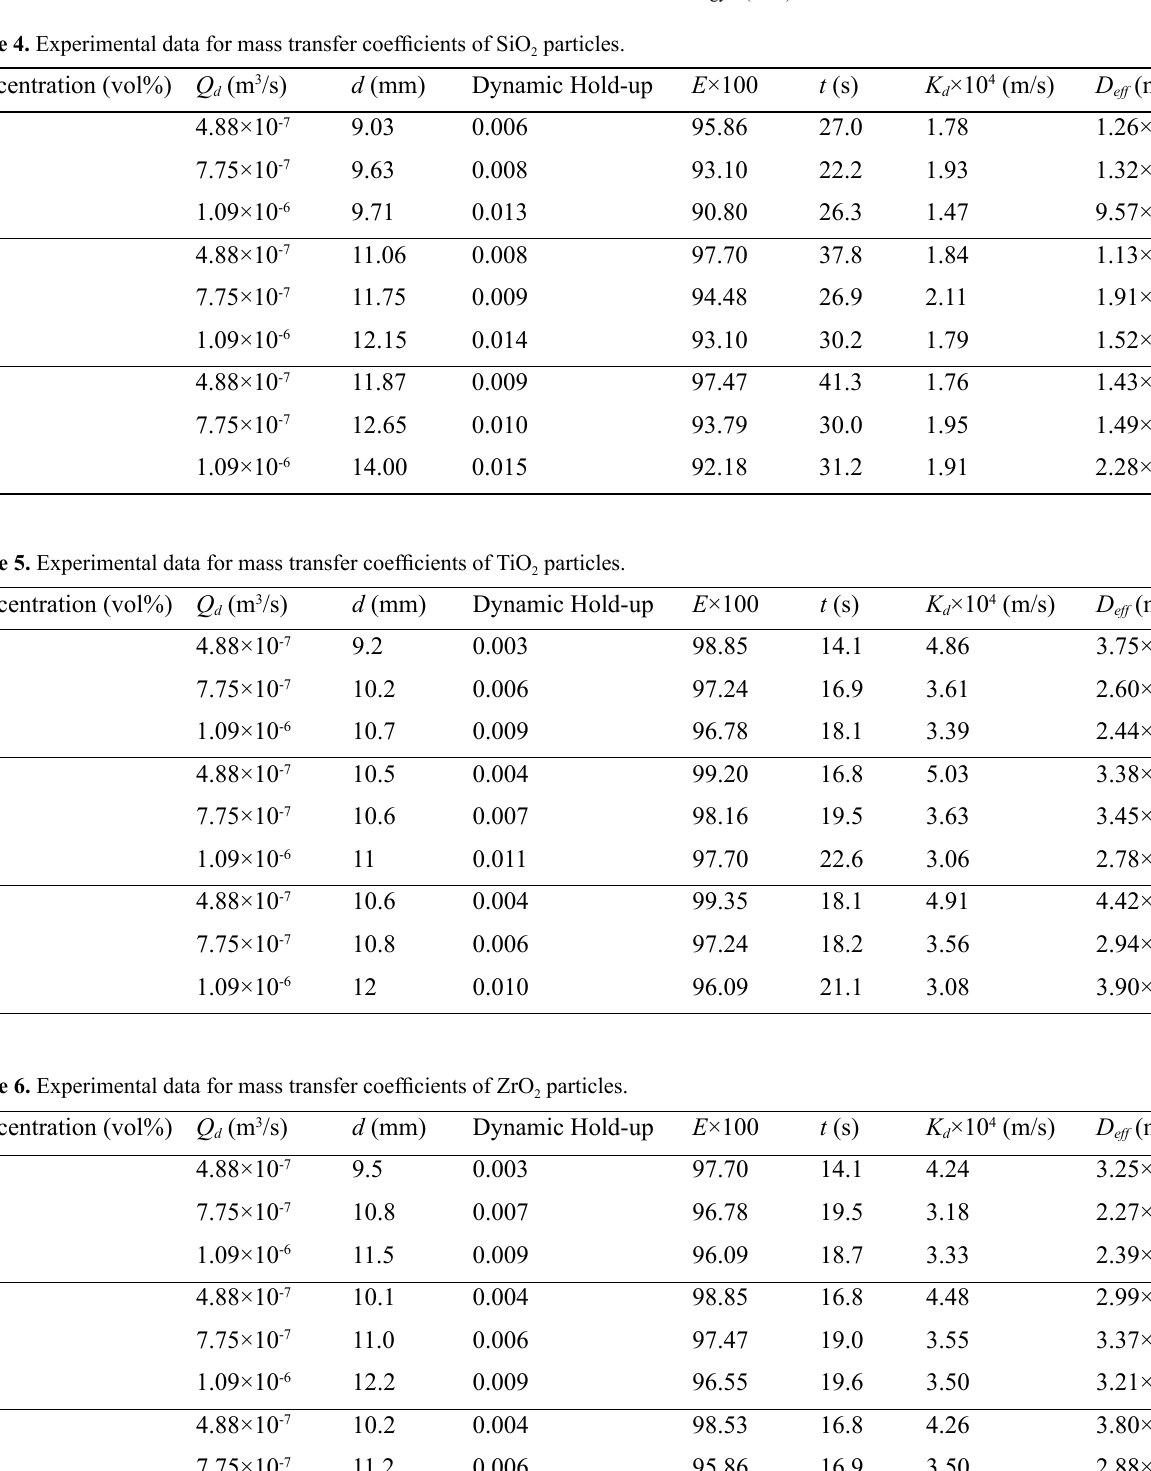
Table 4. Experimental data for mass transfer coefficients of SiO